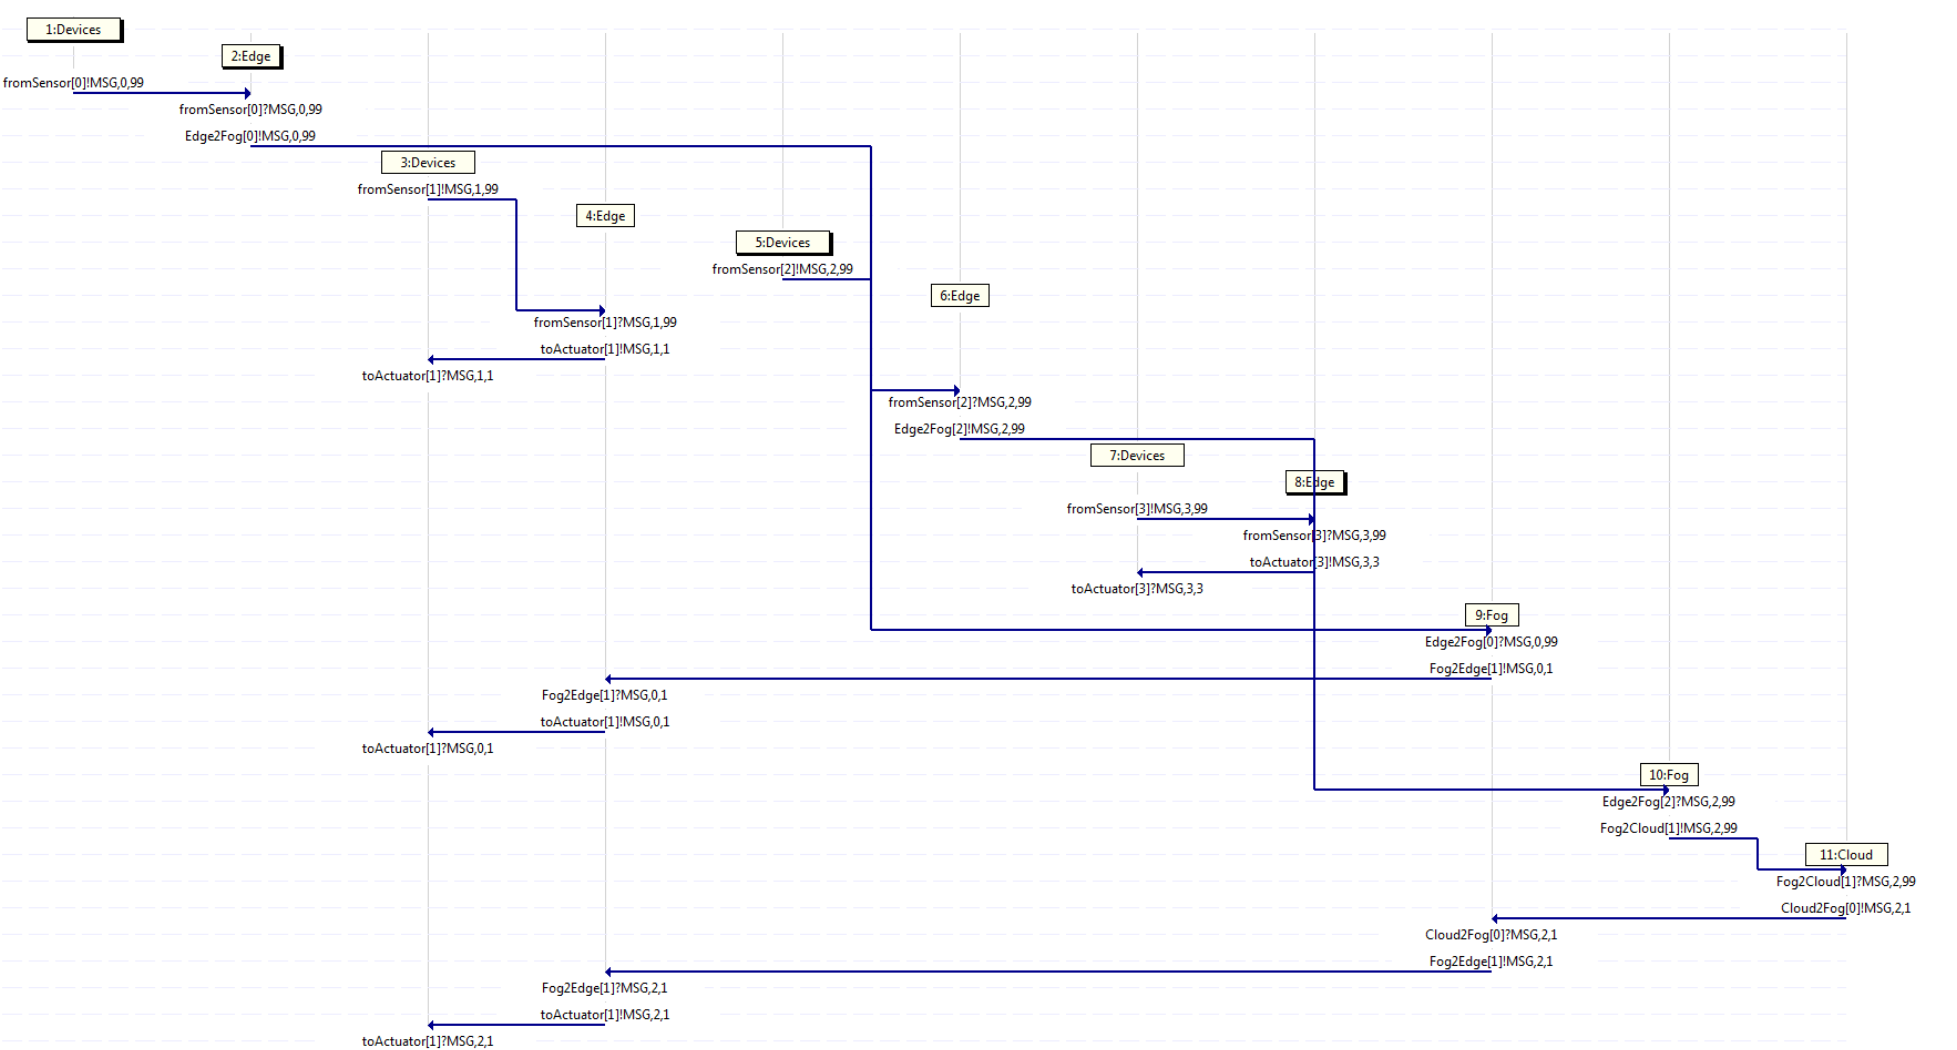
Figure 8. Capture where only edge servers deal with all